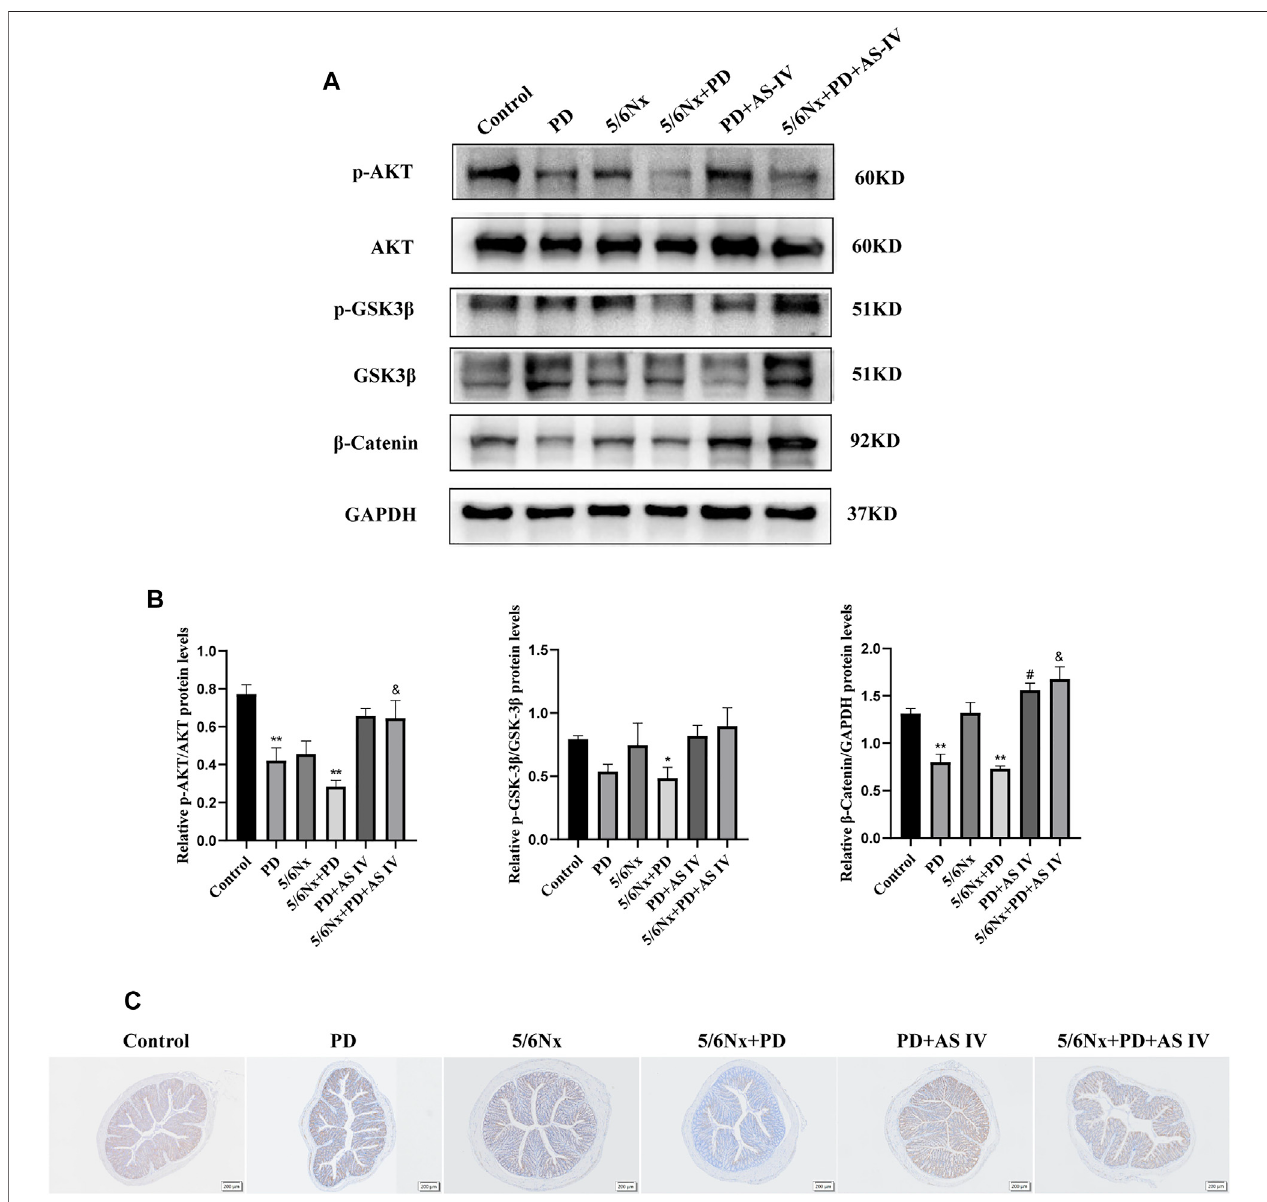
FIGURE 6 | AS IV protected the intestinal mucosa from injury by activating AKT/GSK3 β / β -catenin pathway in PD-treated mice (A,B) The protein expression levels ofAKT,p-AKT,GSK-3 β ,p-GSK3 β ,and β -cateninwereevaluatedbywesternblottingincoloniclysates (C) RepresentativeimagesofIHCstainingfor β -cateninincolonic sections. Data are presented as means ± SD of three independent experiments. * p < 0.05 or ** p < 0.01 versus the control group. # p < 0.05 or ## p < 0.01 versus the PD group. & p < 0.05 or && p < 0.01 versus the 5/6Nx + PD group.